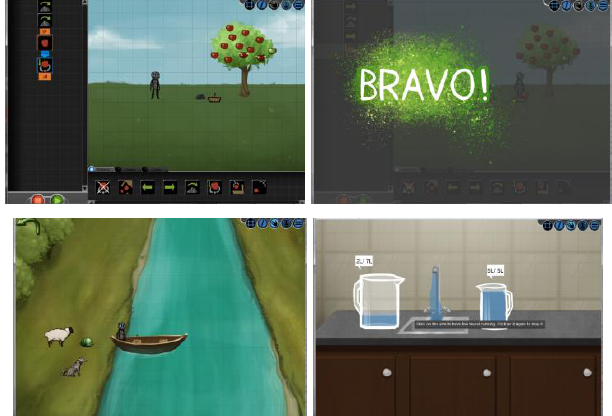
Figure 1. The cMinds environment (http://cminds.org). Visual representation of commands (top left); rewards (top right); exploration area for the river crossing puzzle (bottom left); exploration area for the volume measurement puzzle (bottom